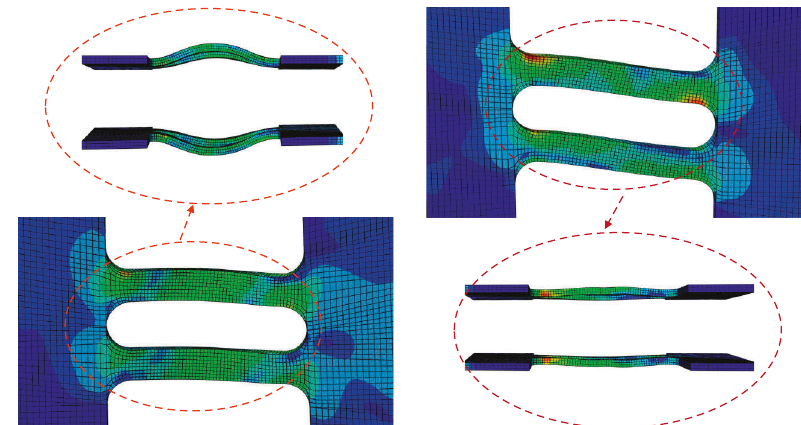
Figure 25: Deformation of RED for FEA simulation.